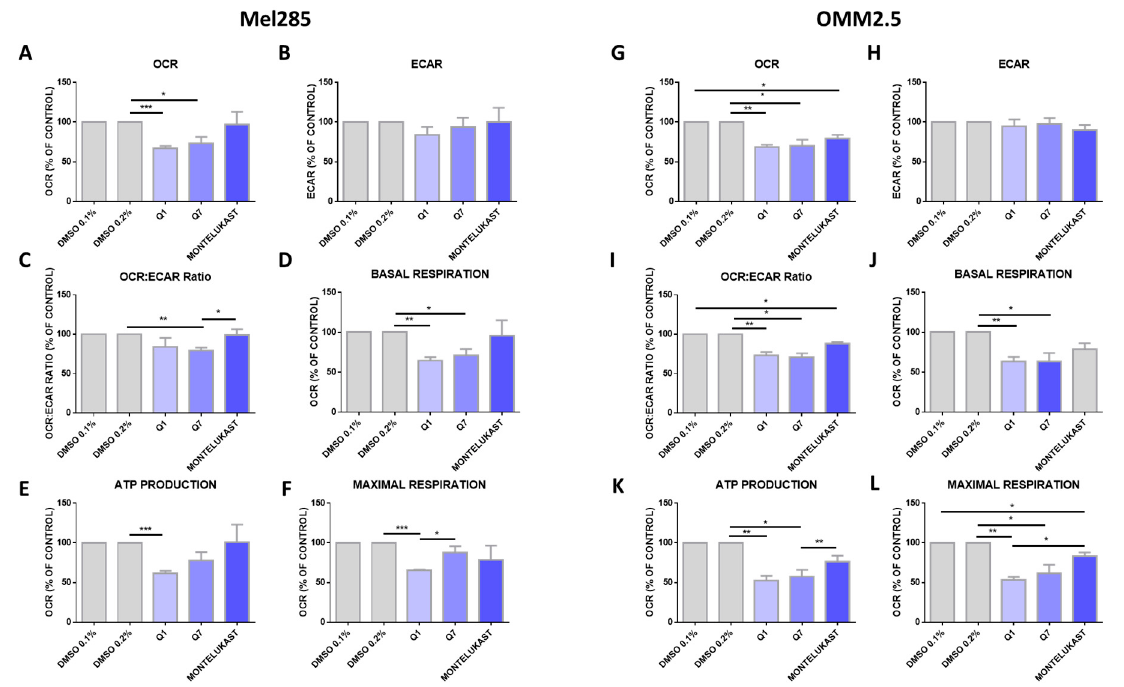
Figure 9. Quininib analogues inhibit oxidative phosphorylation, but not glycolysis, following 24 h treatment in Mel285 and OMM2.5 cell lines. Analysis of cellular metabolism in Mel285 ( A – F ) and OMM2.5 ( G – L ) UM cell lines. Oxygen consumption rate (OCR), a measure of